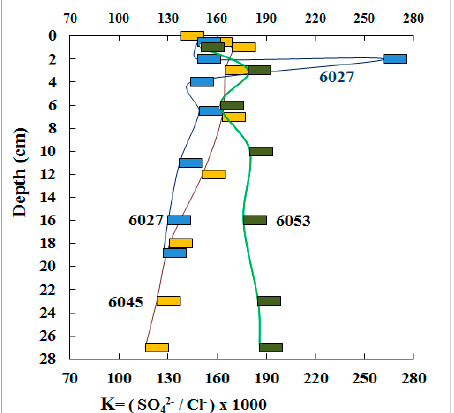
Figure 4. The K coefficient characterizing the ratios between the concentrations of chloride and sulfate ions in pore water of three Laptev Sea shelf sediments.